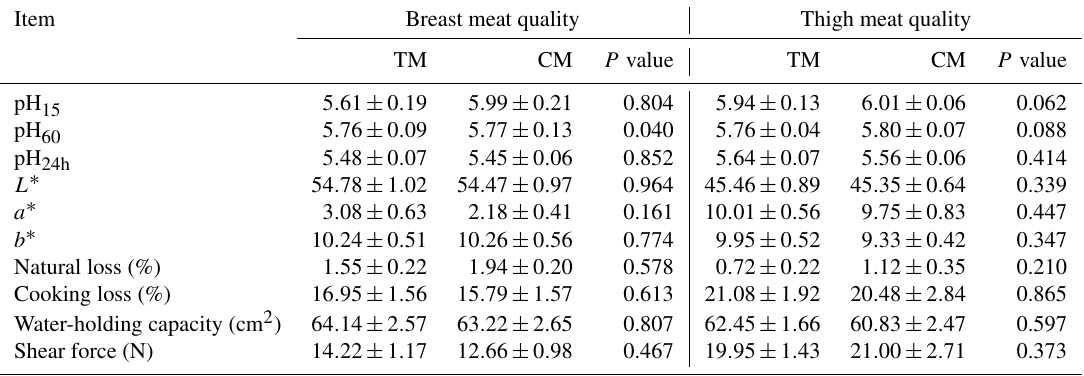
Table 4. Breast and thigh meat quality of guinea fowl in response to diets based on nutrient specifications for three- or two-phased diets (mean ± SEM).